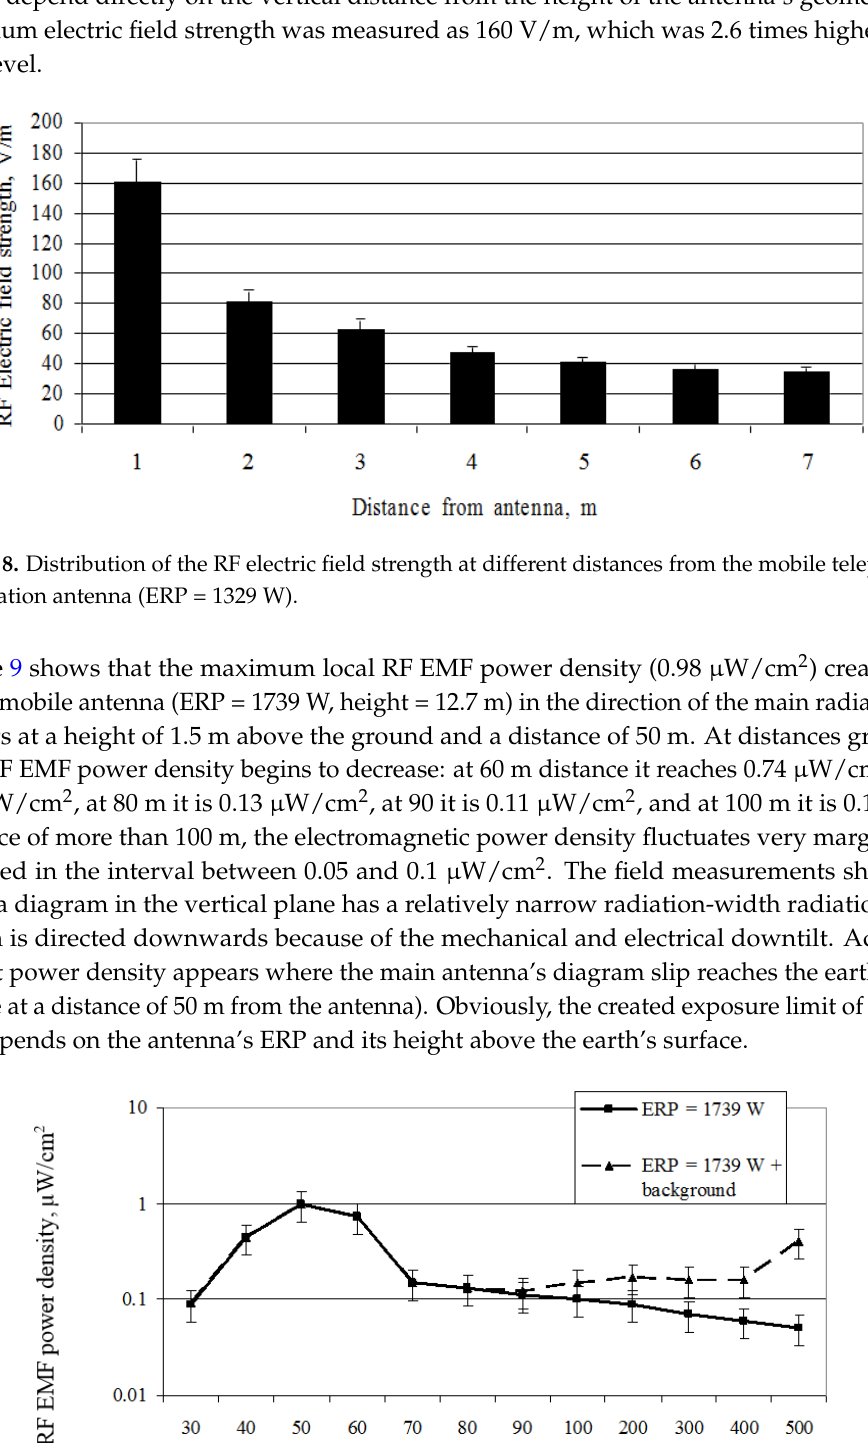
Figure 9. Distribution of the RF power density at different distances from the mobile telephony base station antenna (ERP = 1739 W) and other radio engineering objects (background).